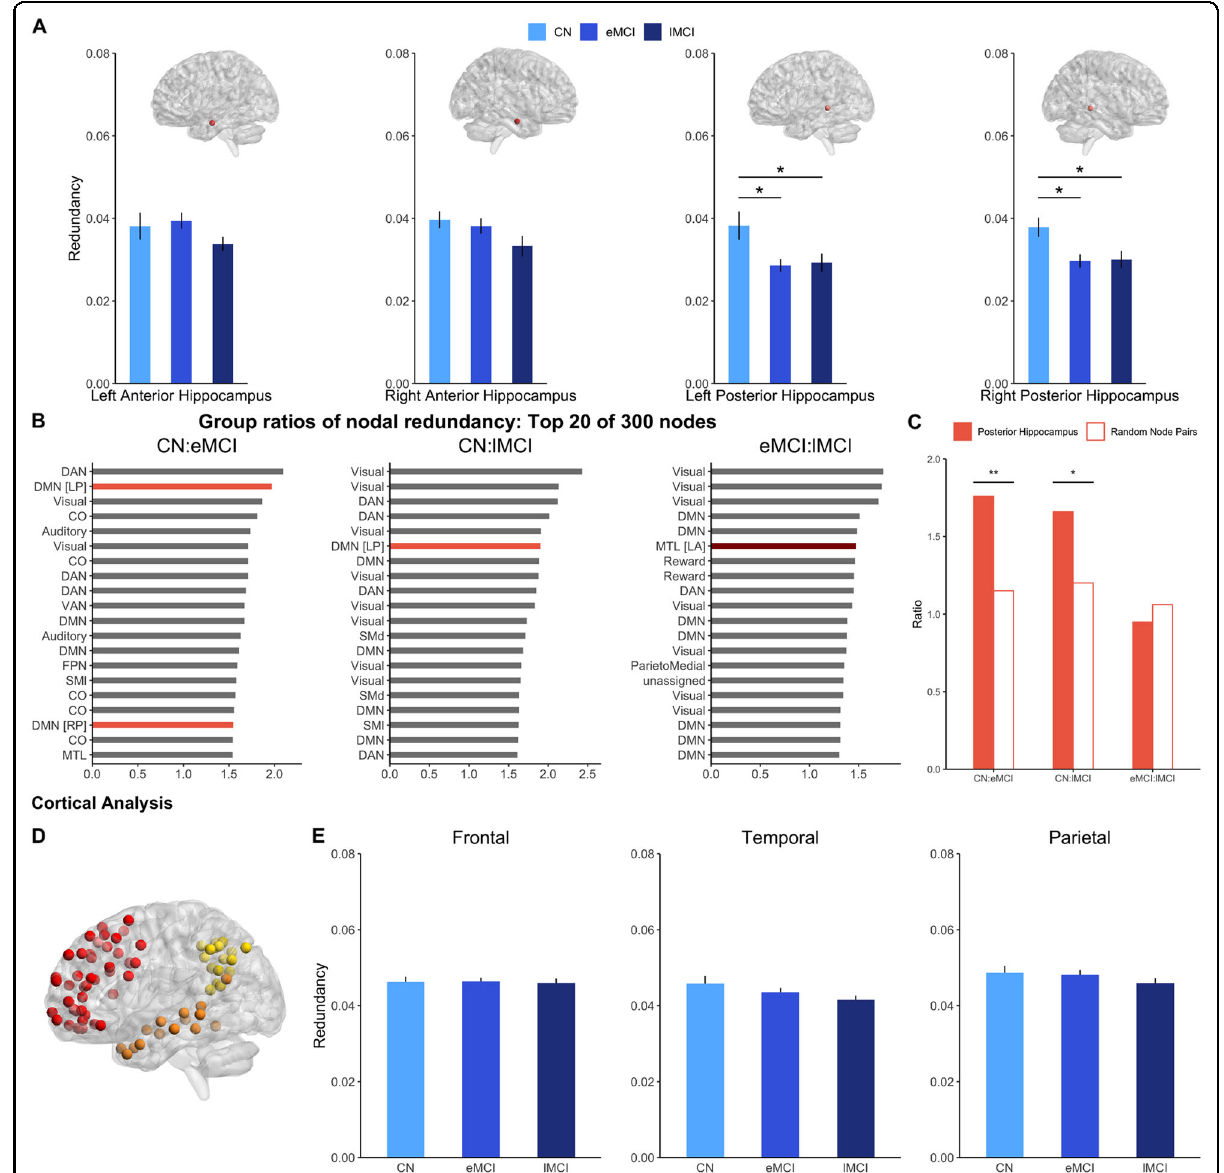
Fig. 2 Hippocampal whole-brain functional redundancy differs in CN and MCI groups. A Group comparisons for the four hippocampal nodes. Error bars represent one SEM. B The top 20 of 300 nodal ratios in each ratio set. Posterior hippocampal nodes (peach) and anterior hippocampal nodes (dark red) are highlighted. Bar labels denote the node ’ s Seitzman et al. 26 network af fi liation. Hippocampal nodes are further labeled with “ LP, ” “ RP, ” “ LA, ” or “ RA ” to represent left posterior, right posterior, left anterior, and right anterior, respectively. C Statistical comparison of the average posterior hippocampal ratio to random node pairs in each ratio set. D Nodes included in the frontal (red), parietal (yellow), and temporal (orange) cortical analysis. E Group comparisons for the cortical nodes. Error bars represent one SEM. * p < 0.05, ** p <